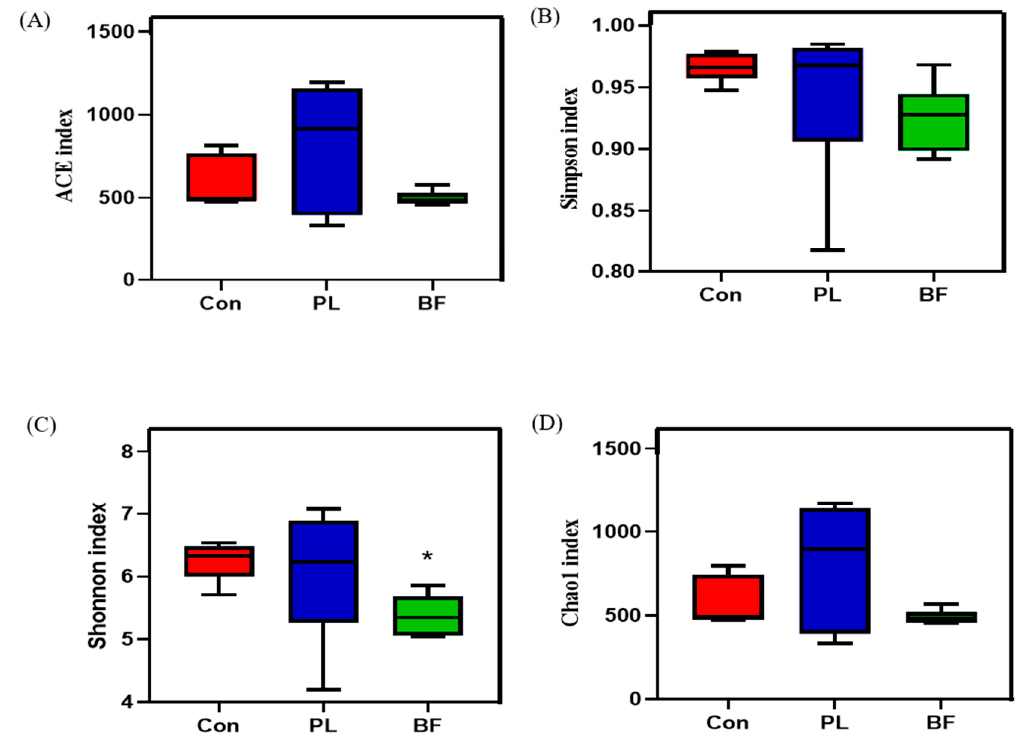
Figure 8. Comparison of bacterial diversity among different bacteria. ACE ( A ), Simpson ( B ), Shannon ( C ), and Chao1 ( D ) indices; *: p < 0.05. All data are presented as mean ± SD. Note: Con means control group; PL means planktonic group; BF means biofilm group.